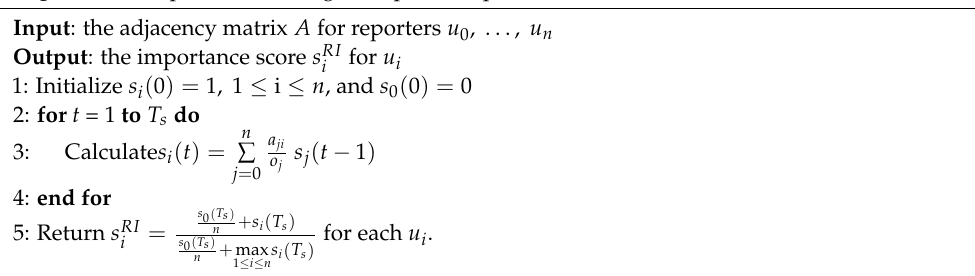
Algorithm 1 Importance scoring for reporter-aspect